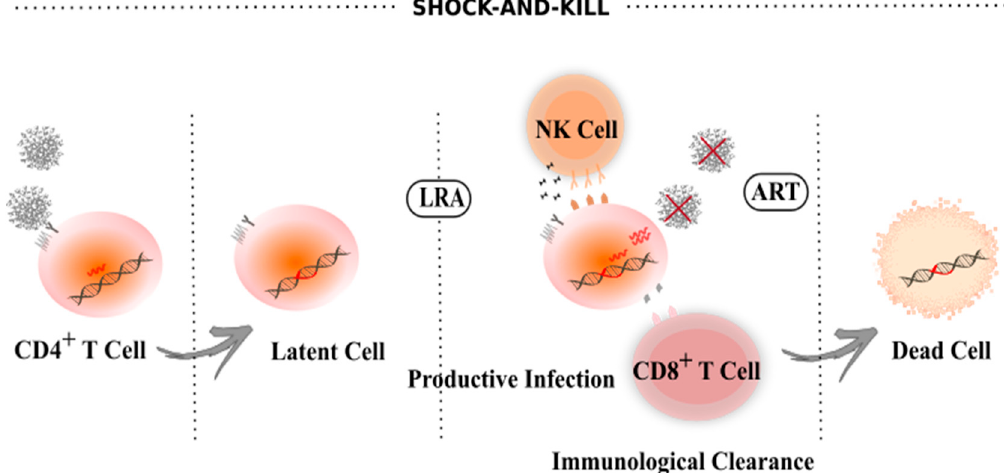
Figure 2. Shock-and-kill approach to eradicate HIV-1 from latently infected cells. During HIV-1 infection, the majority of CD4 + T cells are eliminated through cytopathic effects; the few surviving cells revert to a resting memory state harboring latent proviruses. The shock-and-kill approach uses latency reversal agents (LRA) to increase HIV-1 transcription/replication and virions production. This reactivation leads to the elimination of infected cells by cell cytolysis or immune clearance, and simultaneously the remaining viruses are blocked from novel infections by ART.